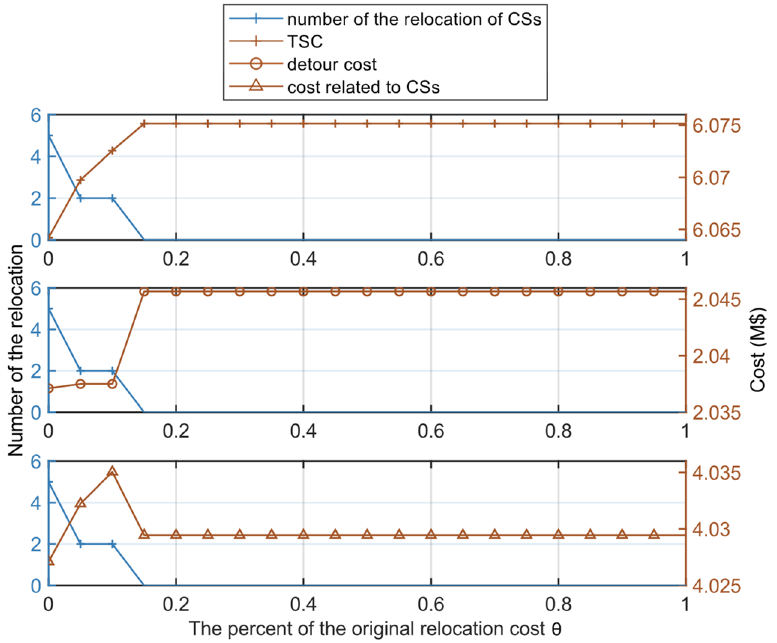
Figure 8. Optimization results with different relocation costs.